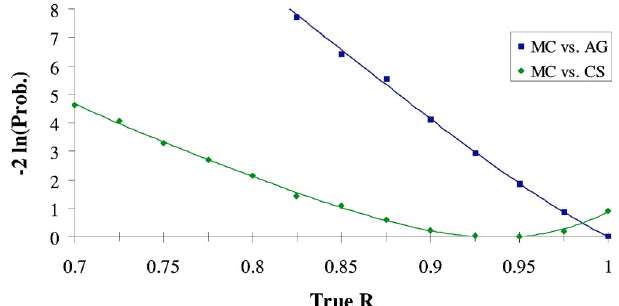
FIG. 4. (cid:1) Color (cid:2) These are maximum likelihood plots for the combined groups of students generated from the simulation data to determine the true correlation coefficient between students’ MC and AG scores and the MC and